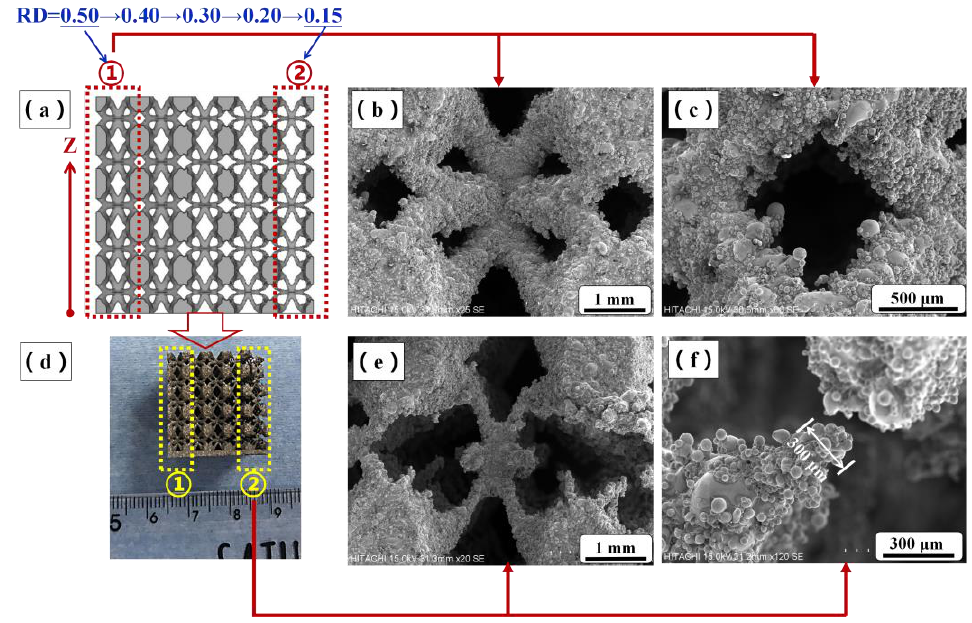
Figure 5. ( a ) CAD model of test lattice structure with RD from 0.15 – 0.50, ( b , c ) SEM micrographs of lattice structure in region ① , ( d ) SLM fabrication result of test lattice structure, and ( e , f ) SEM micrographs of lattice structure in region ② .